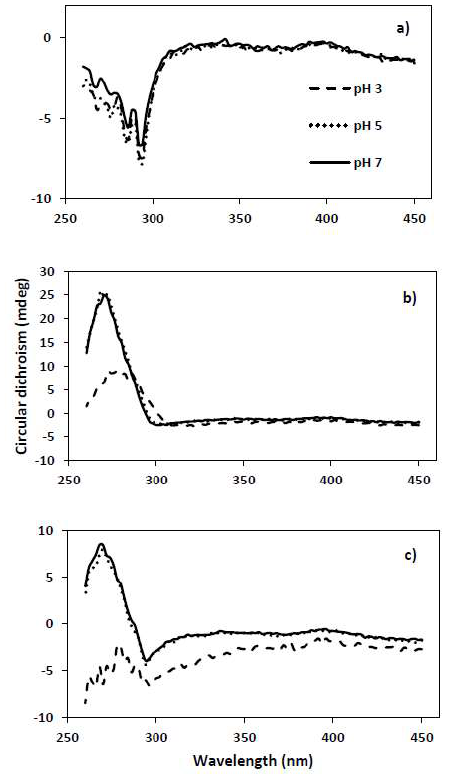
Figure 5. Near-UV CD spectra of ( a ) BLG, ( b ) PGM, ( c ) BLG–PGM mixture at pH 3, 5, and 7.